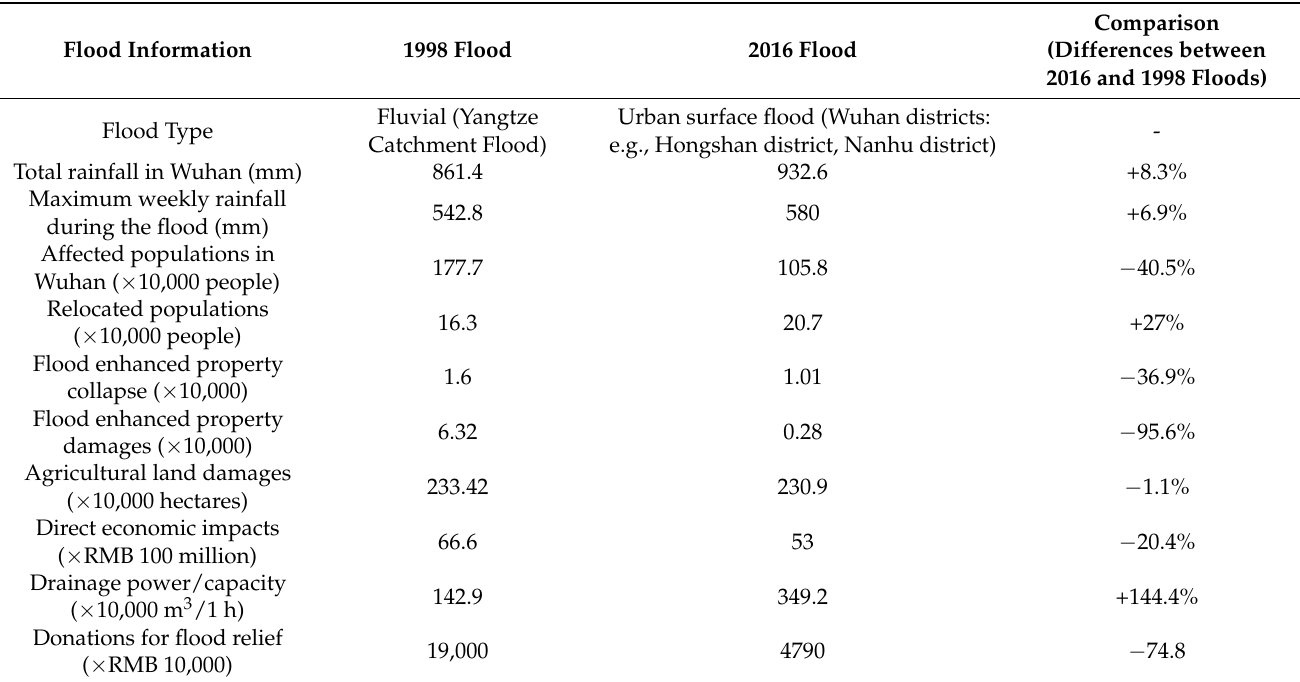
Table 1. Flood status and impacts in Wuhan between 1998 and 2016 flood events